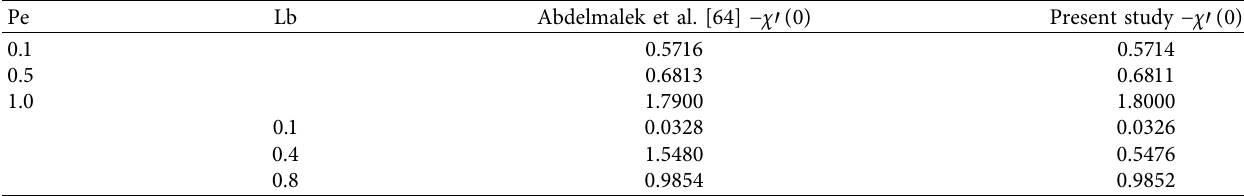
Table 3: Comparison of the present study with that of Abdelmalek et al. [64] when β �